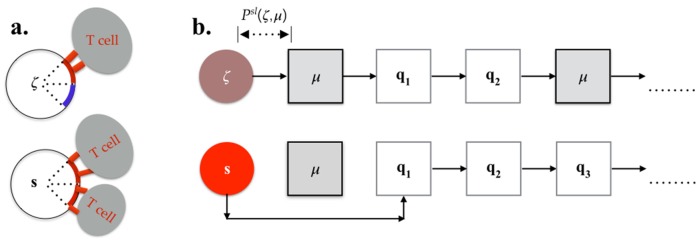
Discrimination between autoreactive and antigen specific B cells.A: Sketch showing an autoreactive B cell with half of its pMHC consisting of self antigens (the blue arc) and the other half consisting of non-self pMHC (red arc). Tfh cells (ellipses with TCRs as red rectangles) recognize only the non-self pMHC. B: Cross reactive B cells can recognize autoreactive Tfh cells (grey boxes) while antigen specific B cells don’t, leading to different survival probabilities. A particular sequence of non-self and self Tfh cells that react with the B cells is shown as an example.